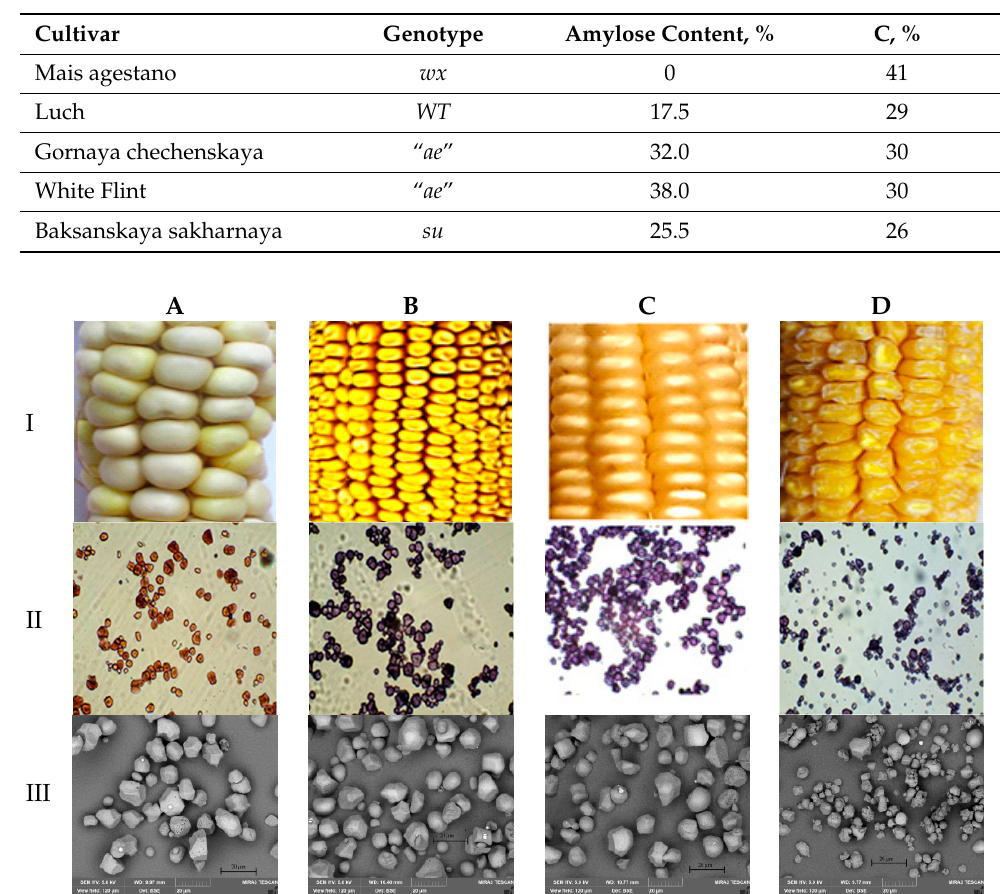
Table 2. Crystallinities C of starch samples calculated on the basis of XRD data.